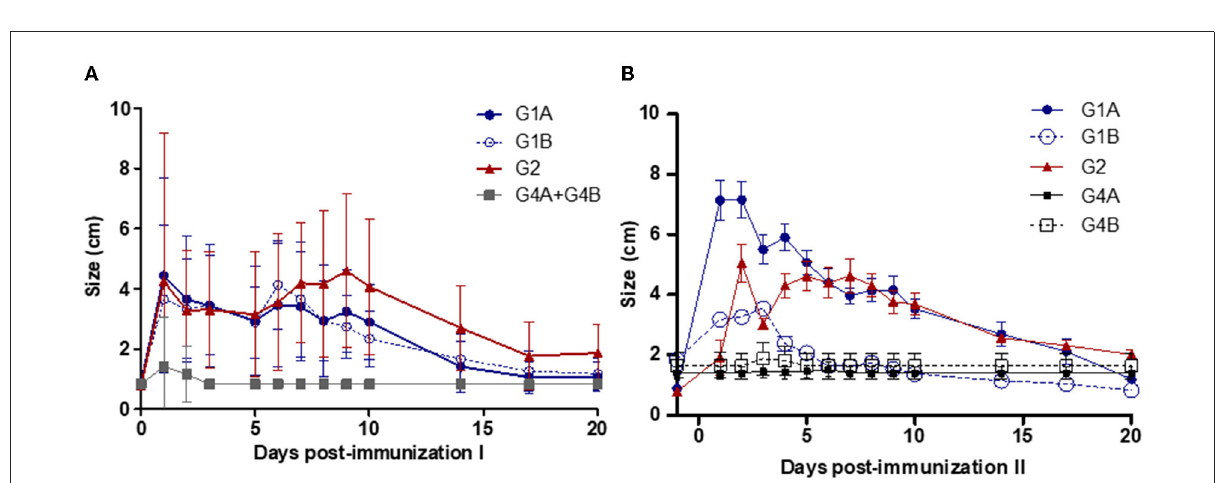
FIGURE2 Local reaction sizes after the first (A) and second (B) immunizations. Immunized groups: Trichobovis administered by subcutaneous (SC; G1A) or intravulvar (IVU; G1B) routes and TrichGuard by SC route (G2). Non-immunized groups received PBS injections via SC (G4A) or via IVU (G4B) routes. Each point represents the mean and standard deviation of the local reaction sizes (cm; Y-axis) measured at different sampling times (X-axis; days